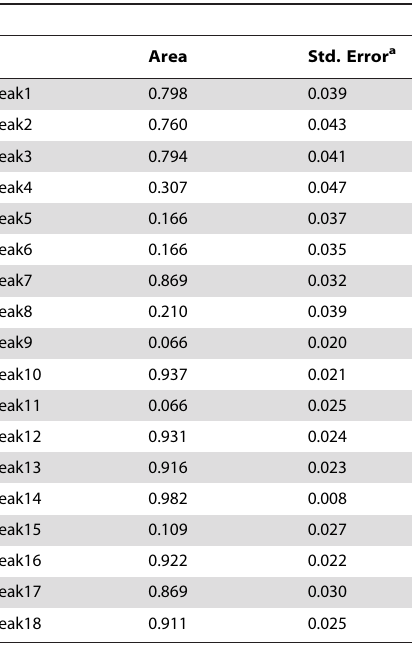
Table 4. Area under the curve of the 18 discriminatory